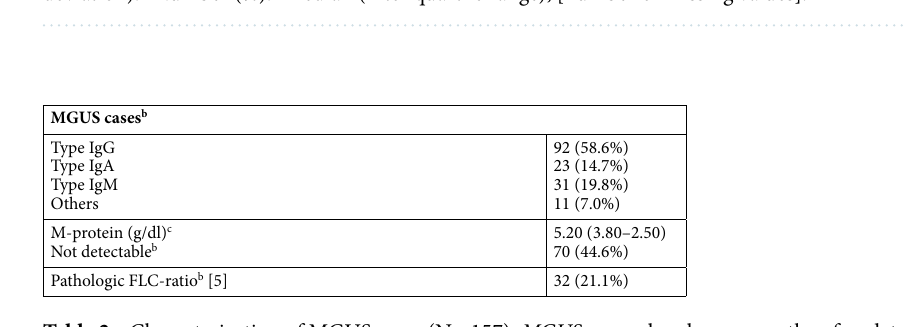
Table 2. Characterization of MGUS cases (N = 157). MGUS monoclonal gammopathy of undetermined significance. b Number (%). c Median (inter quartile